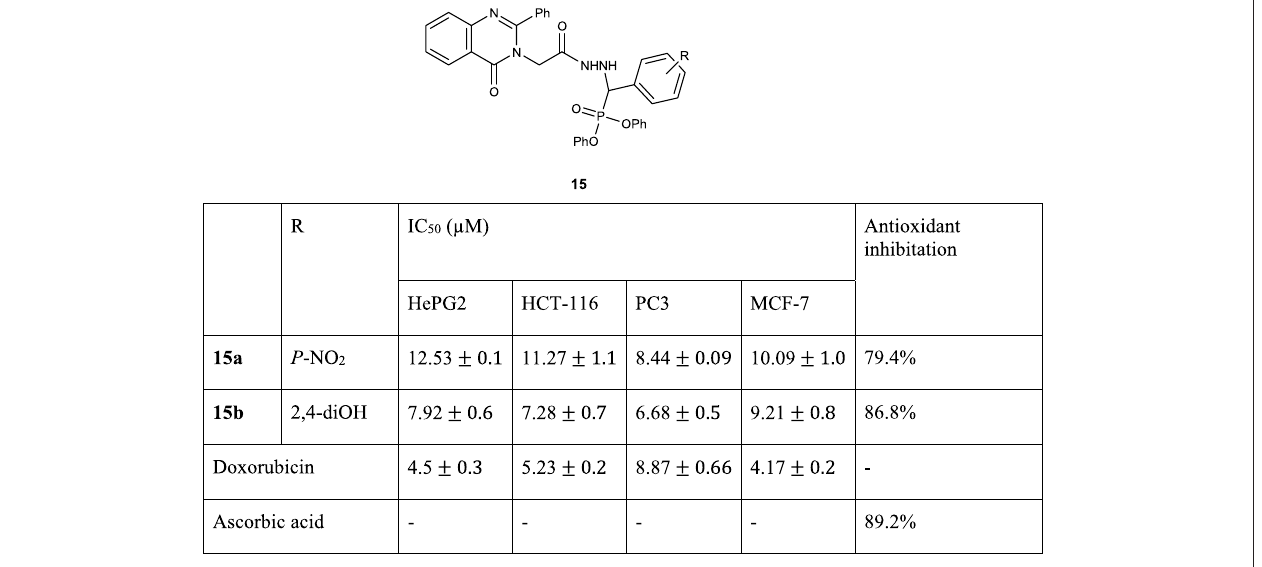
FIGURE 3 | Structures of the compound 15 and its biological